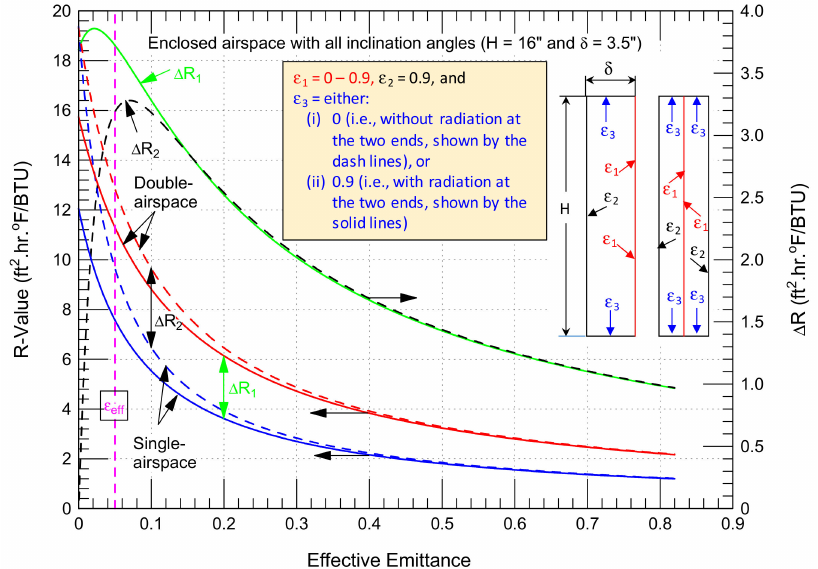
Figure 3. Comparisons of the thermal resistances for single and double airspaces in the absence of heat transfer by convection with end effect (i.e., ε 3 = 0.9) and without end effect (i.e., ε 3 = 0.0) at H = 16 inches, total δ = 3.5 inches, T H = 90 ◦ F, T L = 60 ◦